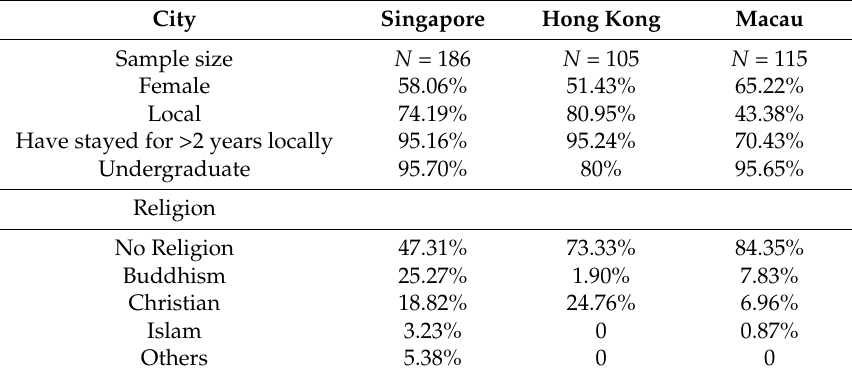
Table 1. Summary of sample.